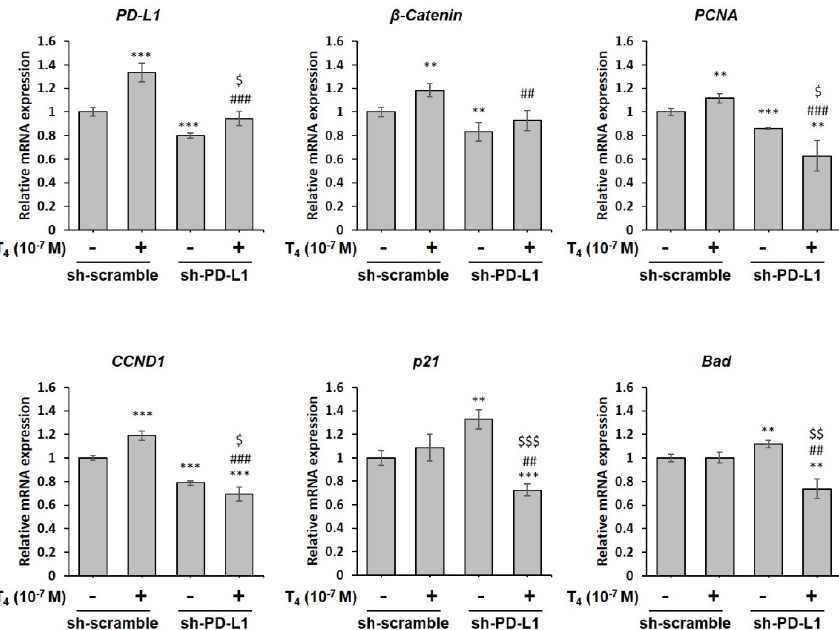
Figure 6. Thyroid hormone (T 4 )-induced PD-L1 controls β-catenin expression in human oral cancer cells. OEC-M1 cells were seeded in six-well trays and transfected with PD-L1 shRNA or a scrambled plasmid (0.5 µg/well) were treated with 10 −7 M T 4 for 24 h. Cells were harvested, and RNA was extracted. A qPCR was conducted for proliferation-related genes. Data are presented as the mean ± SD. Results are from three independent studies ( n = 4) ** p < 0.01, *** p < 0.001, compared to the control; ## p < 0.01, ### p < 0.001, compared to T 4 , and $ p < 0.05, $$ p < 0.01, $$$ p < 0.001, compared to PD-L1 shRNA group.